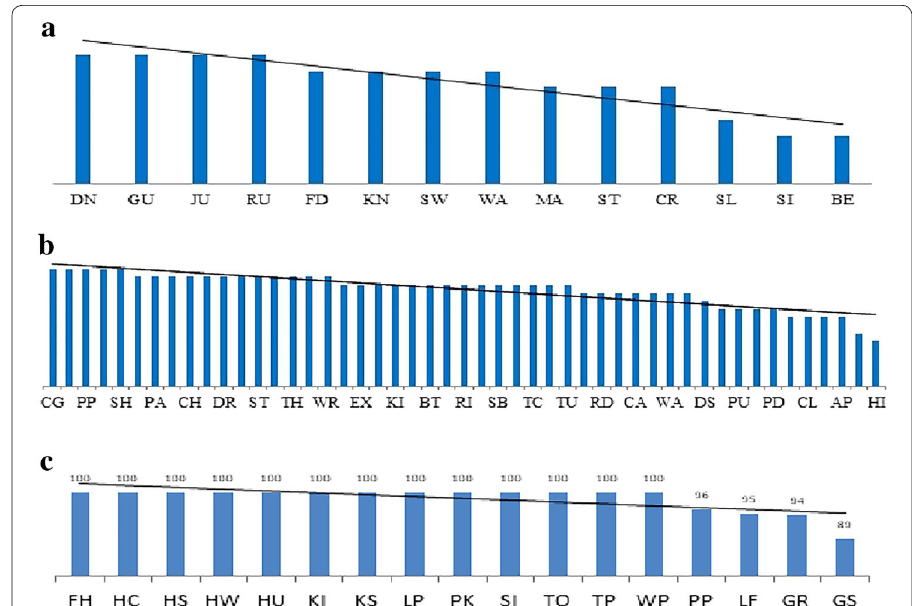
Fig. 10 Prediction accuracy of 3 categories of interactions using YOLO v3 on various classes in AVA dataset; a human atomic actions; b human–object interactions and c human-to-human interaction